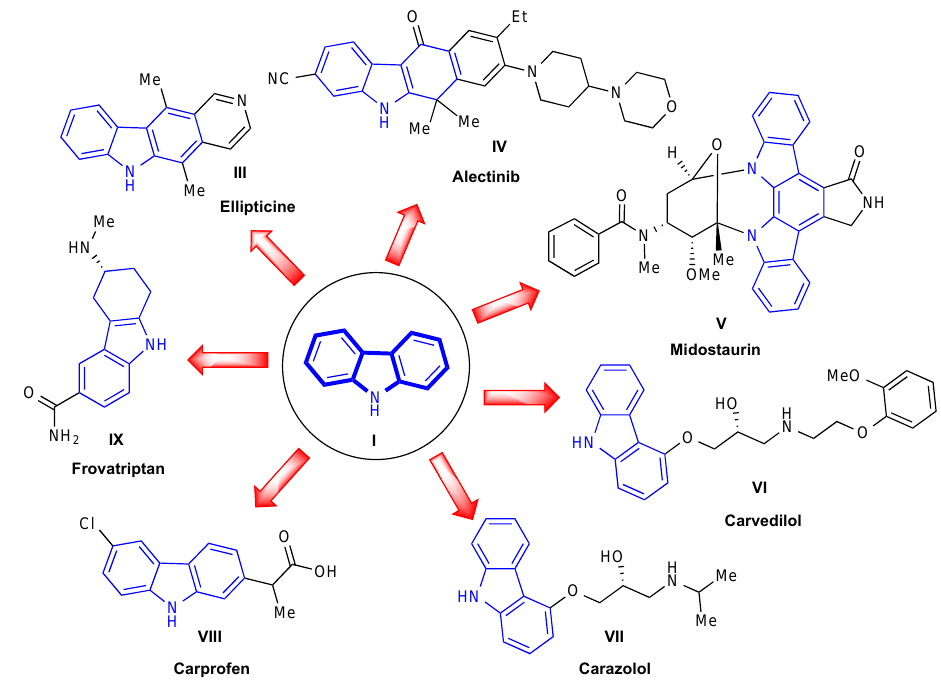
Figure 2. Structures of notable carbazole ring containing approved drugs. Carvedilol ( VI ) was approved in 1995 to treat high blood pressure and congestive heart failure (CHF) [25]. Carazolol ( VII ) is a truncated analog of carvedilol and was ap-